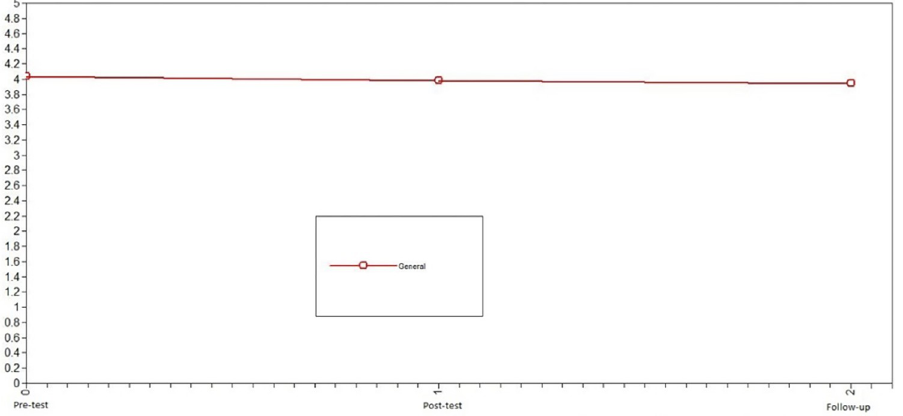
Fig 9. Latent growth curve models of prosocial behavior toward family of the control group. The best fit in the control group was the model of decreasing linear change.